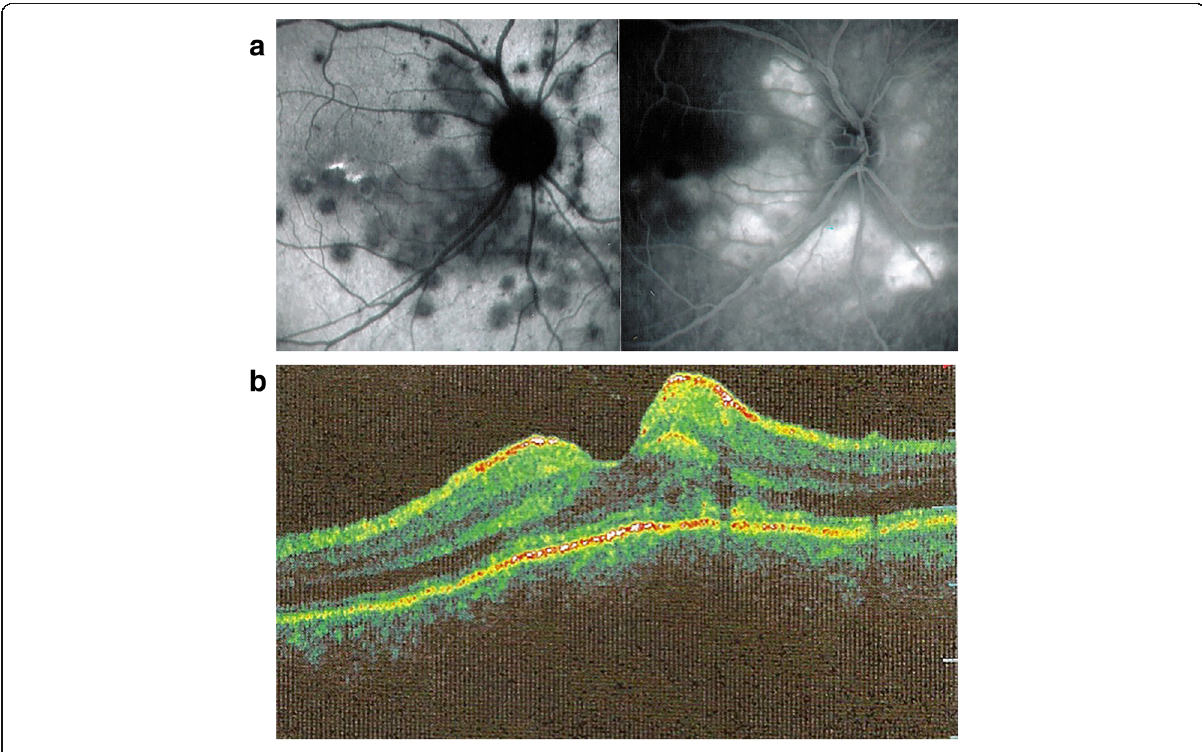
Fig. 6 Multifocal choroiditis (MFC). ICGA & FA of acute episode. Areas of ICGA hypofluorescence around optic disc indicating severe choriocapillaris non-perfusion (left picture). On the right image, late FA frame showing diffuse hyperfluorescence due to pooling of dye in the retinal and subretinal space due to probable exudation from retinal vessels due to severe outer retinal ischaemia, as shown in another case